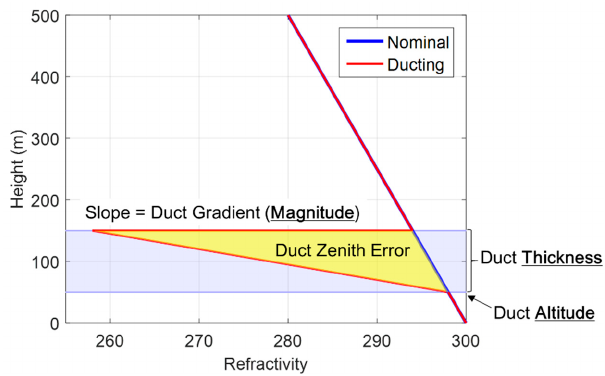
Figure 2. Three ‐ parameter wedge model for duct anomaly [11]. Figure 2. Three-parameter wedge model for duct anomaly